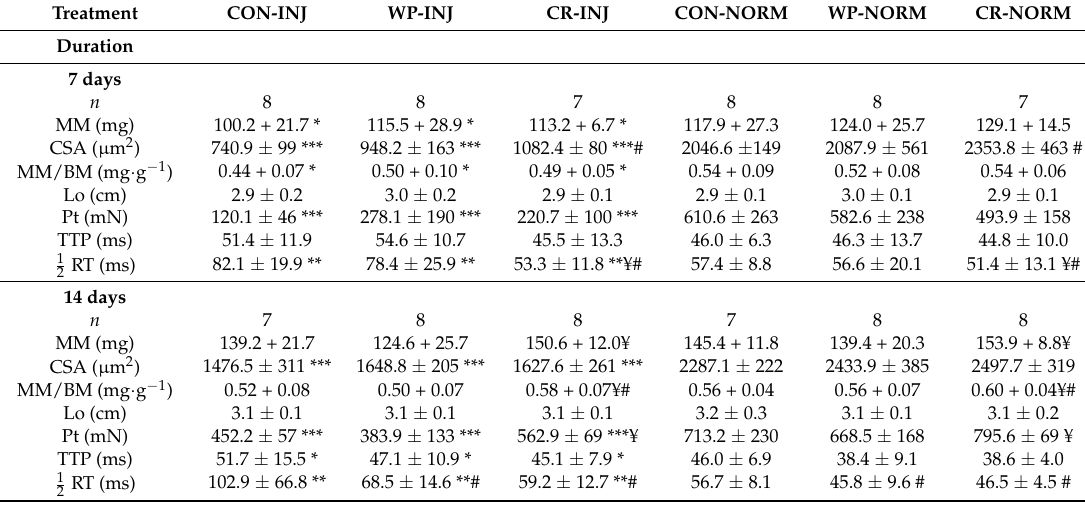
Table 2. Morphometric and contractile properties of uninjured and injured EDL muscles from rats treated with standard rat chow- (CON), whey protein- (WP), or creatine- (CR) supplemented rat chow at 7 and 14 days post-injury. Treatment CON-INJ WP-INJ CR-INJ